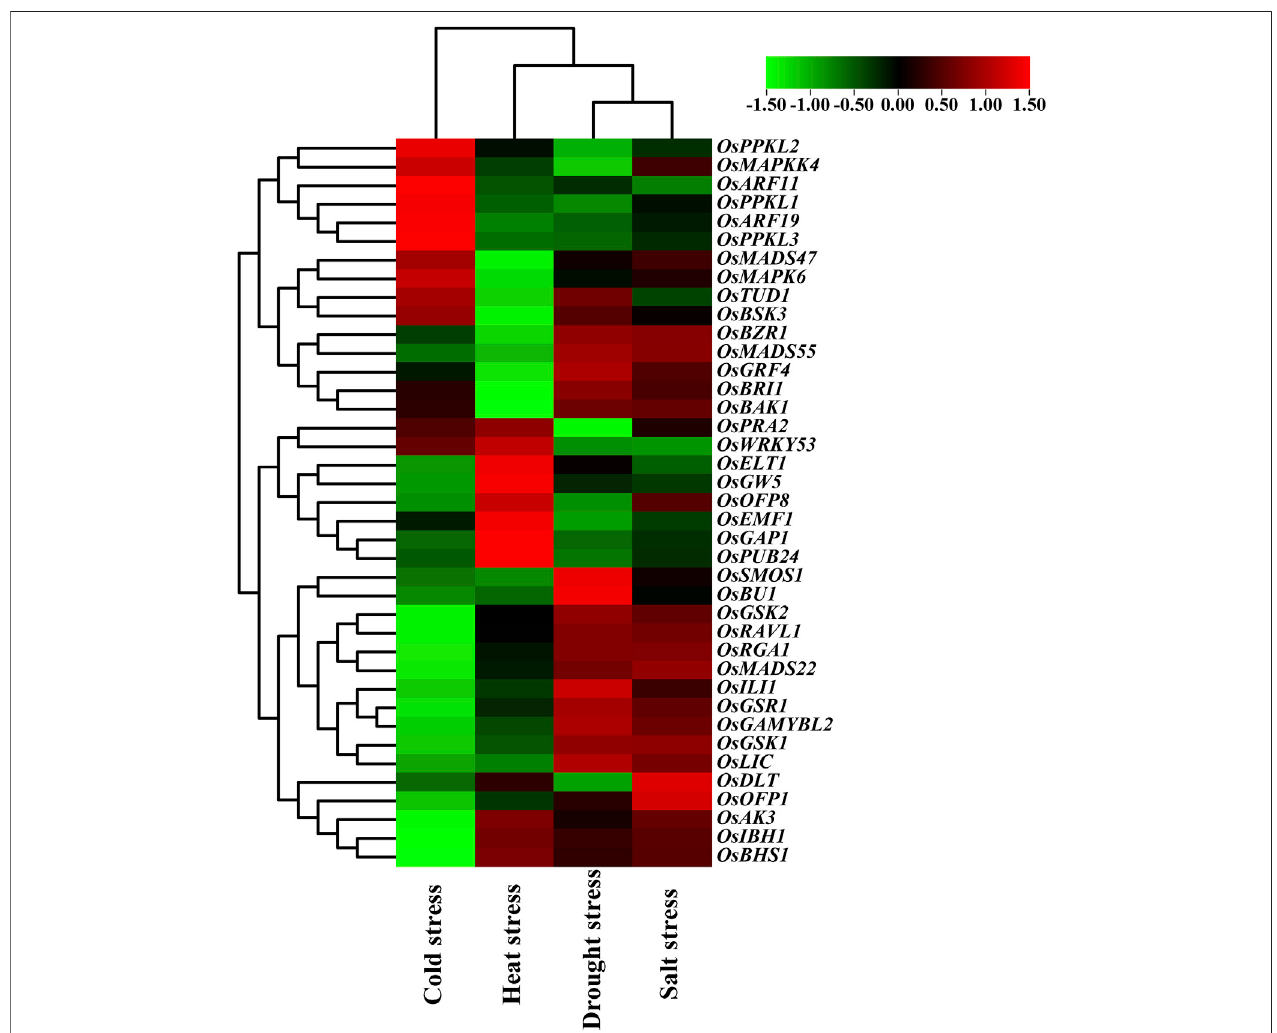
FIGURE 8 | Expression pattern of the BR signaling genes in response to abiotic